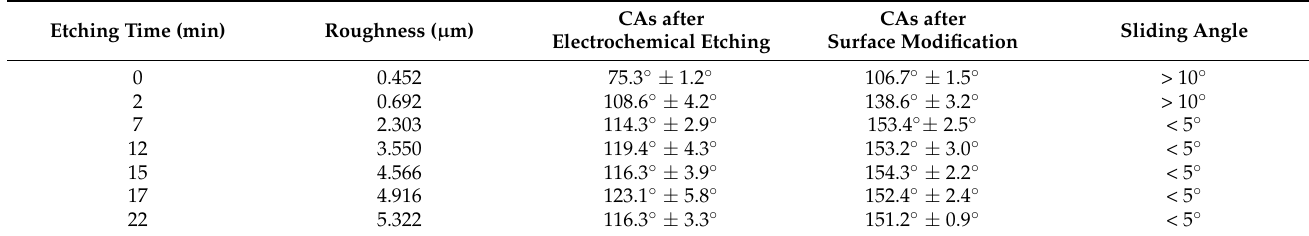
Table 1. Contact angle (CA), sliding angle and roughness of Zr-based metallic glasses at different electrochemical etching